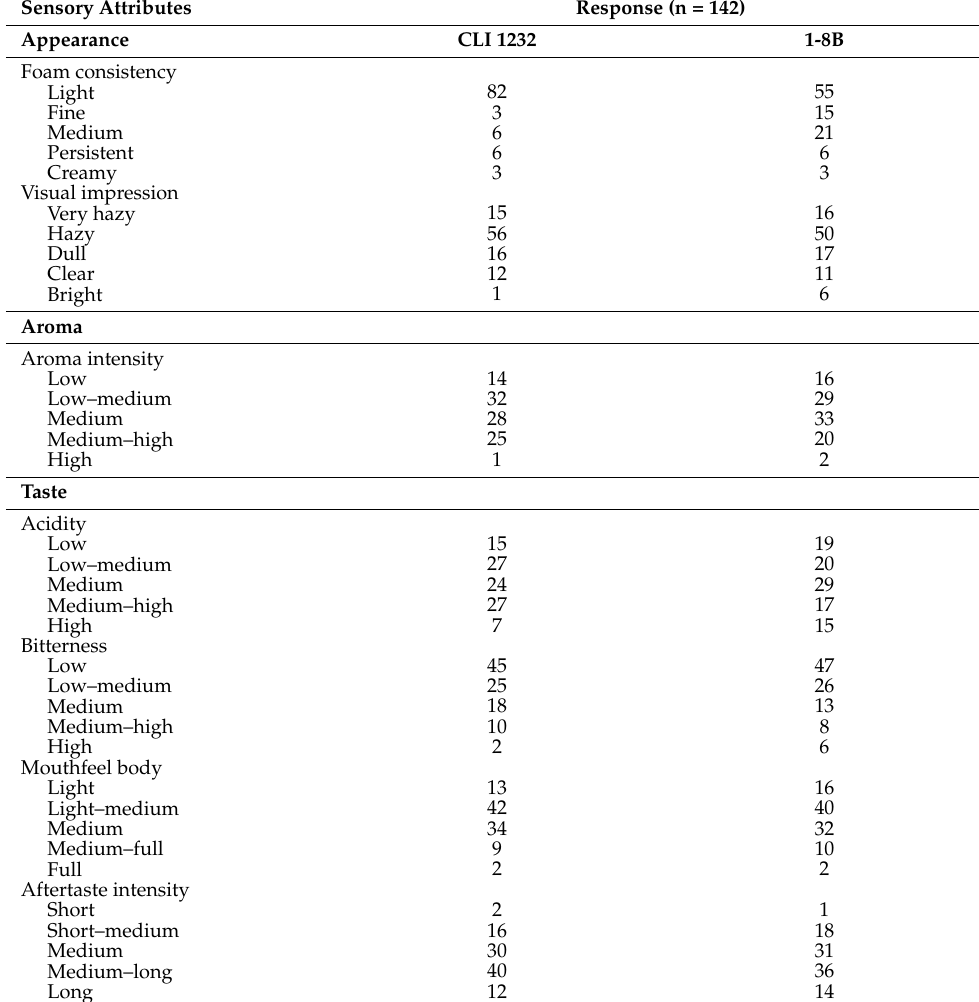
Table 7. Analysis of the data frequency obtained by CATA questions expressed as percentage of consumers